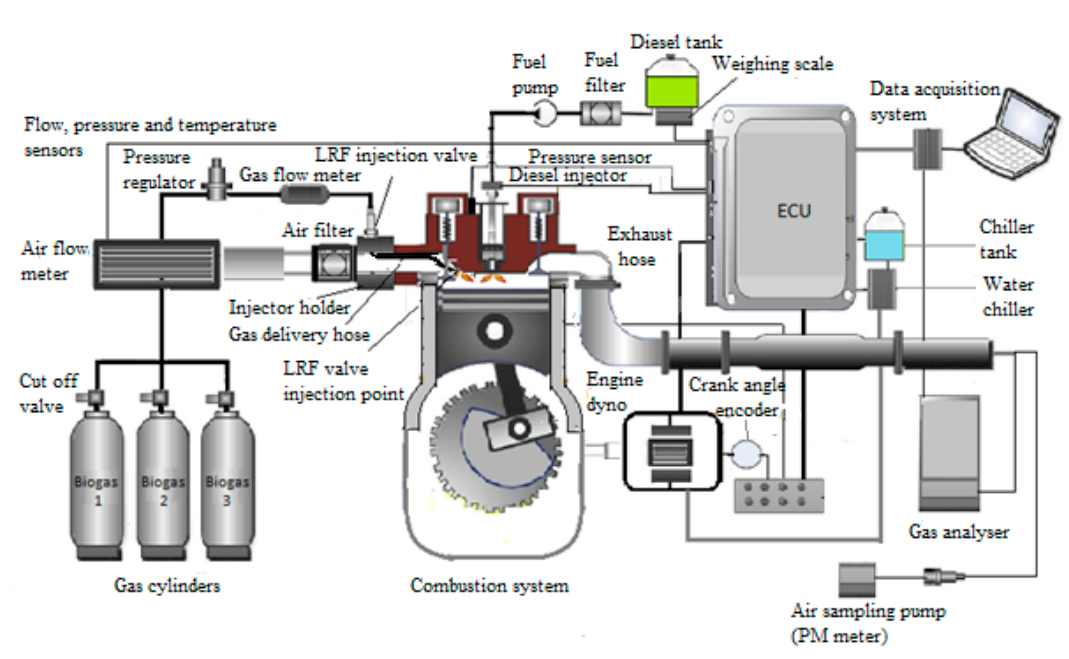
Figure 2. An illustration of the engine test rig.